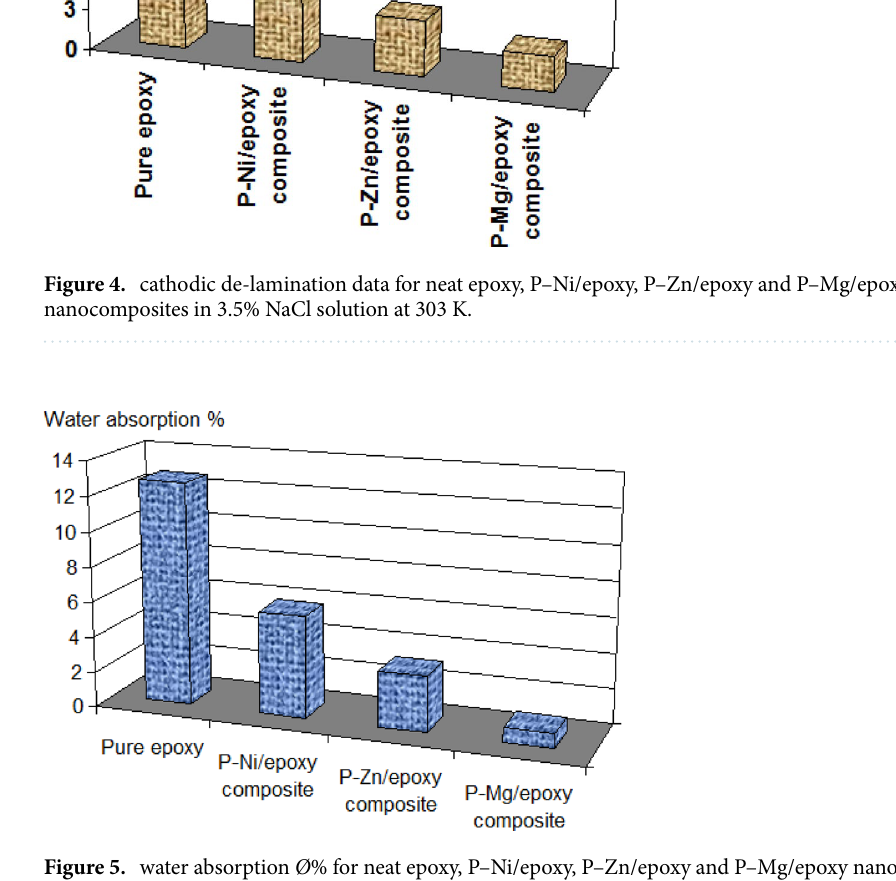
Figure 5. water absorption Ø % for neat epoxy, P–Ni/epoxy, P–Zn/epoxy and P–Mg/epoxy nanocomposites.